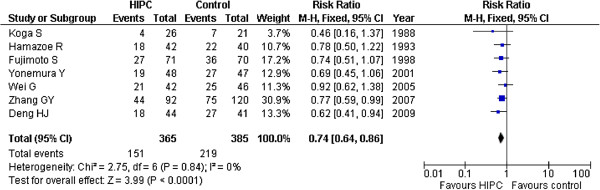
Sensitivity analysis for overall survival: high-quality studies (Jadad score ≥≥≥ 4).